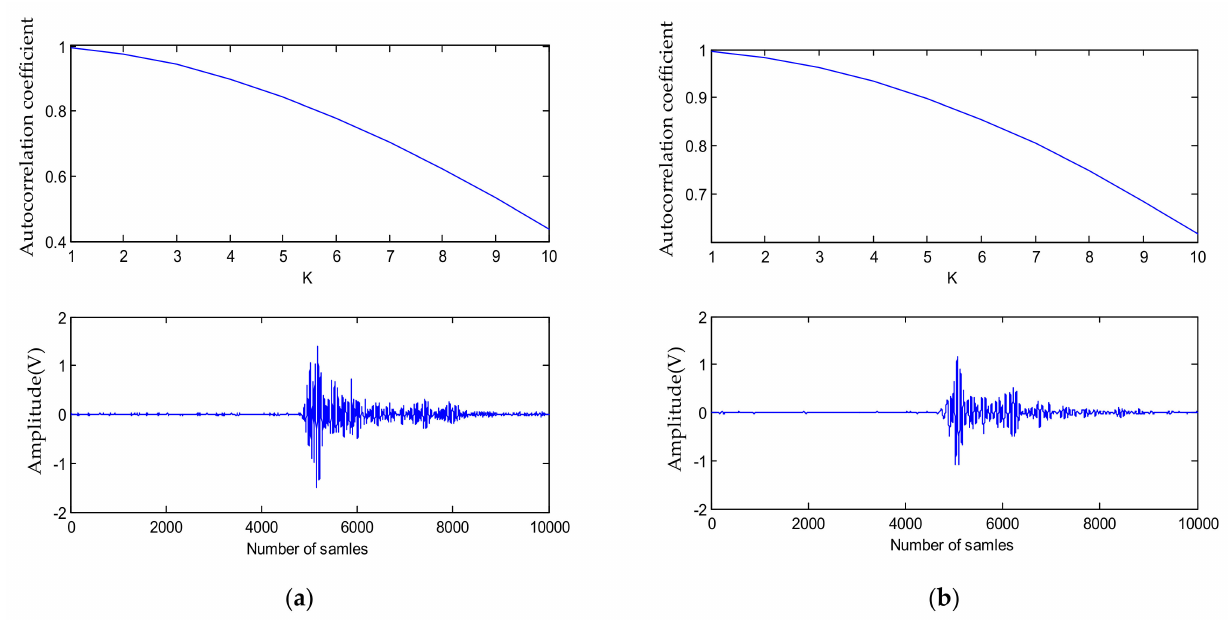
Figure 2. ( a ) Fifth-layer autocorrelation coefficient and detail component; ( b ) sixth-layer autocorrelation coefficient and detail component.